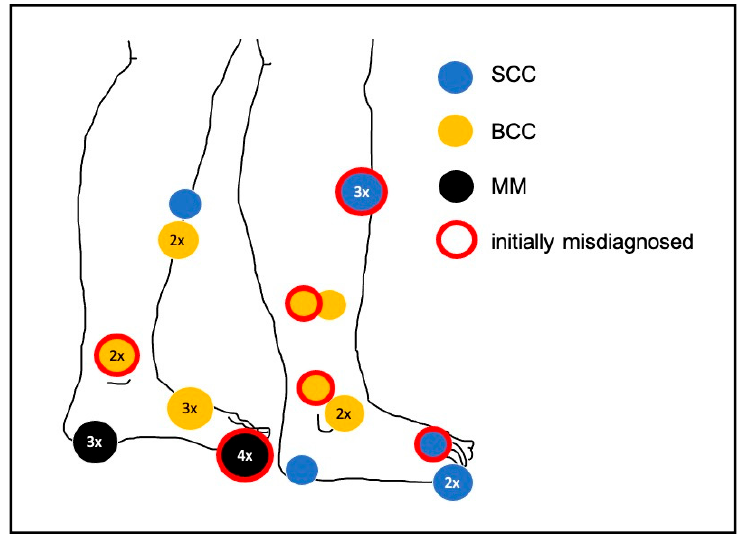
Figure 2. Locations of the malignant tumours presenting as chronic ulcers. For example, four misdiagnosed melanomas were situated on the hallux. SCC—squamous cell carcinoma; BCC—basal cell carcinoma; MM—melanoma. Table 1. Case characteristics.